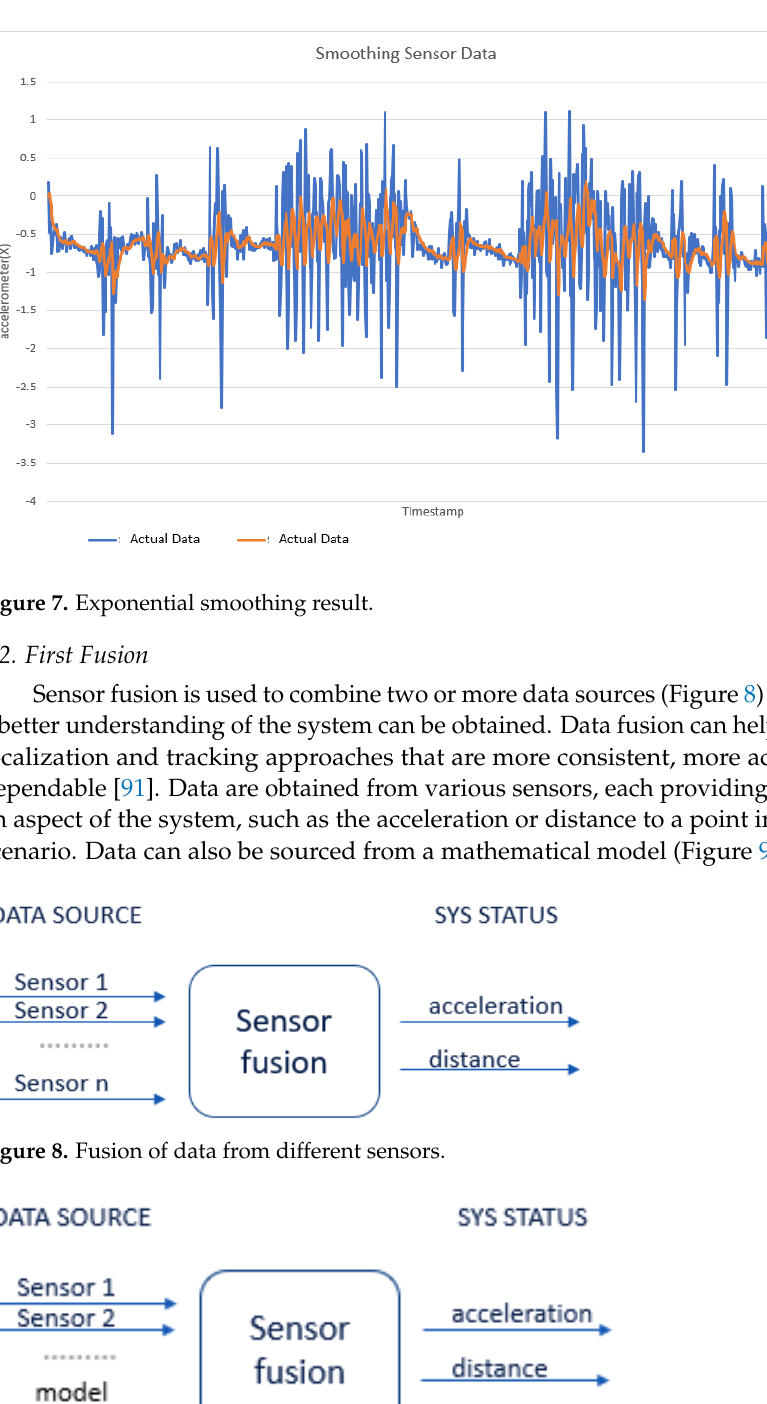
Figure 6. Acceleration sensor at point 1, showing data noise.